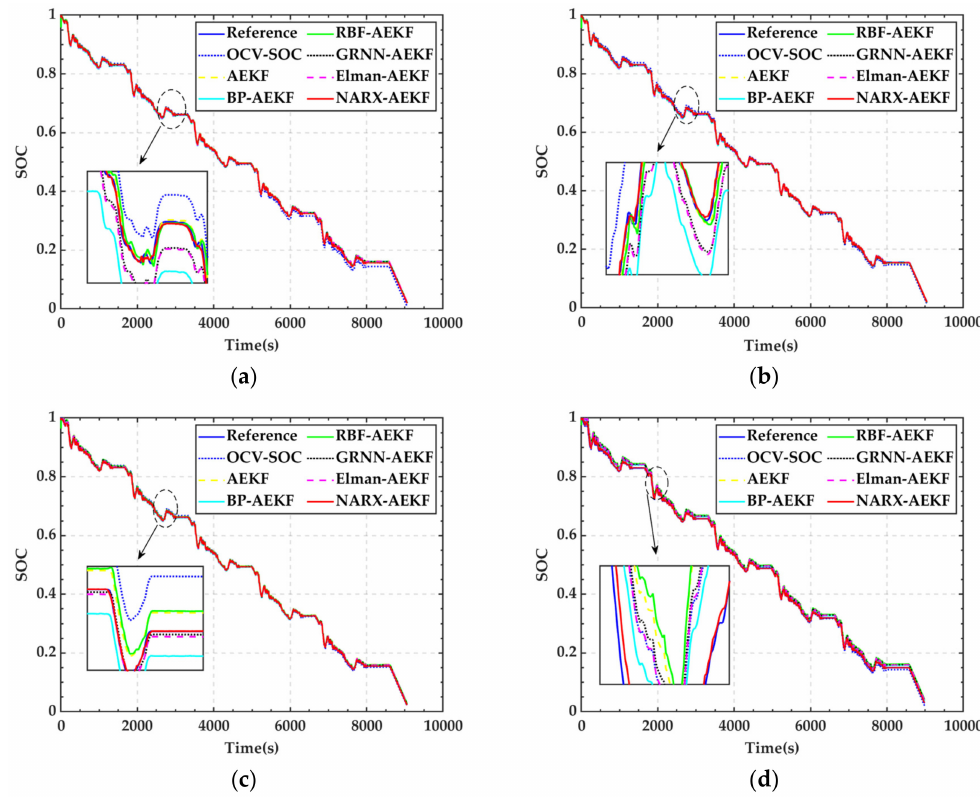
Figure 8. The SOC estimation results of seven methods at different temperatures: ( a ) SOC estimation results at − 10 ◦ C; ( b ) SOC estimation results at 10 ◦ C; ( c ) SOC estimation results at 25 ◦ C; ( d ) SOC estimation results at 40 ◦